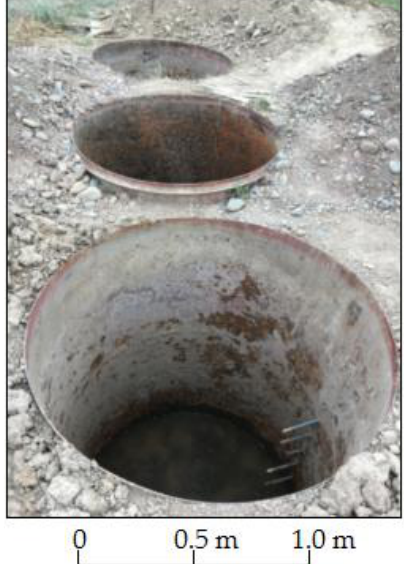
Figure 3. Empty cylindrical test barrels.